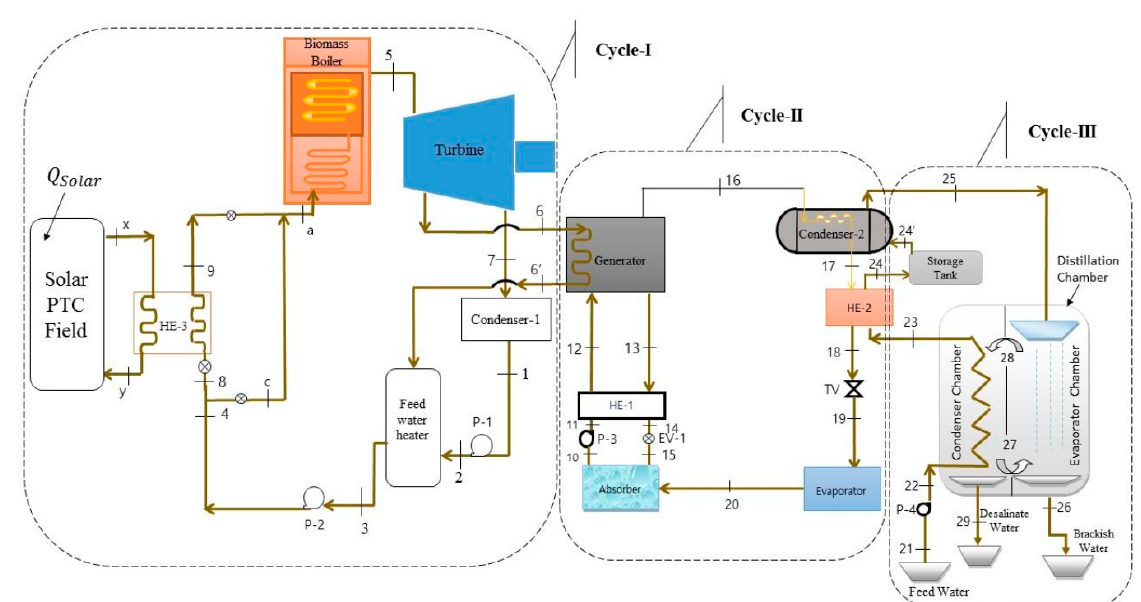
Figure 10. Schematic diagram of the hybrid solar-biomass power plant with cooling and multi-effect humidification-dehumidification (HDH) desalination proposed by Sahoo et al. [87].